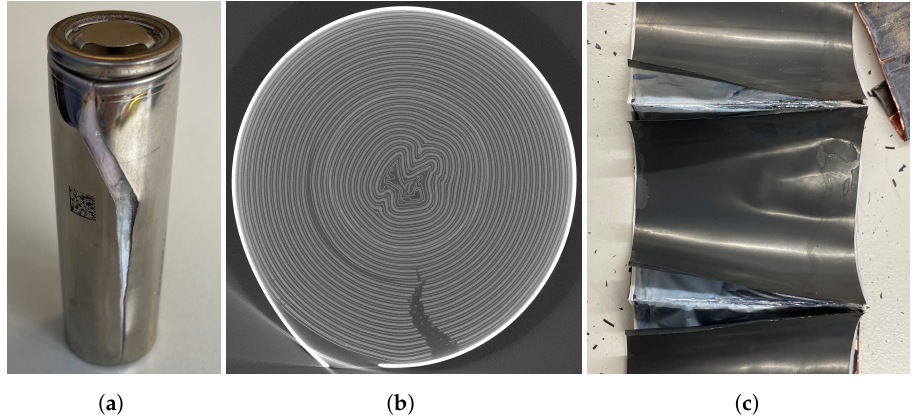
Figure 1. Failure of the cell case of a LG INR21700-M50 with fractured electrode after cycling with 0.5 C and 4.2v to 2.5v limits at 10°C. Excessive internal pressure caused electrode and case rupture. Separators remained intact and prevented a thermal event. ( a ) Battery cell with ruptured case. ( b ) CT scan showing filled inner space and fractured electrodes. ( c ) Post mortem analysis showing electrode rupture while separators remained